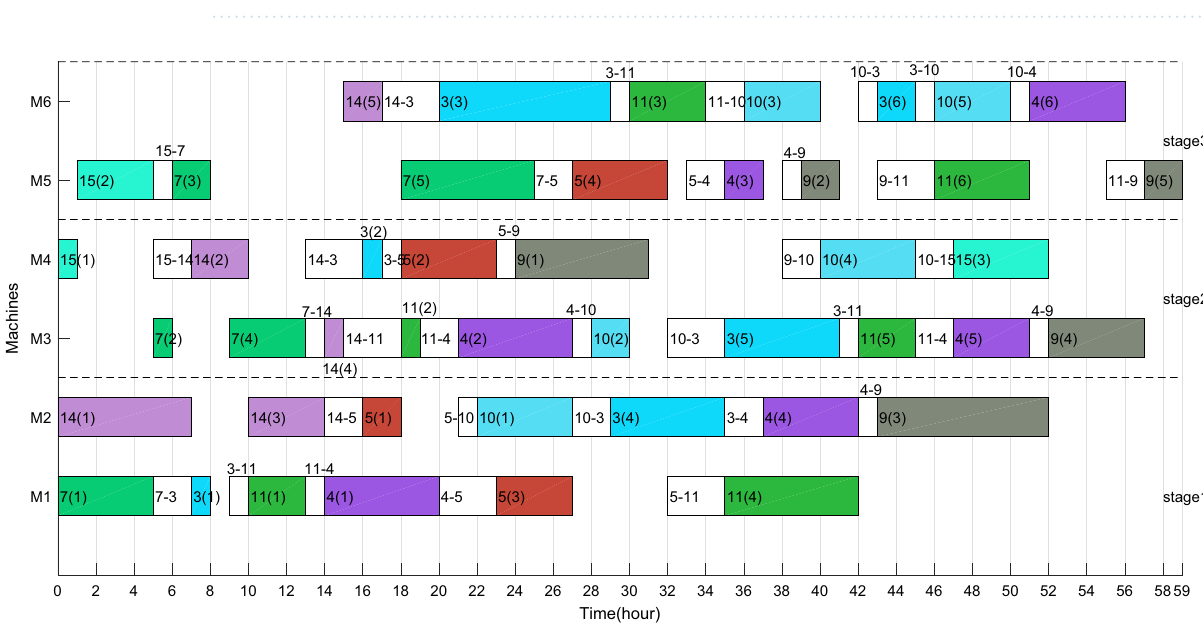
Figure 20. The Gantt chart of instance f2j15s3r1 in factory2 without considering TOU price.